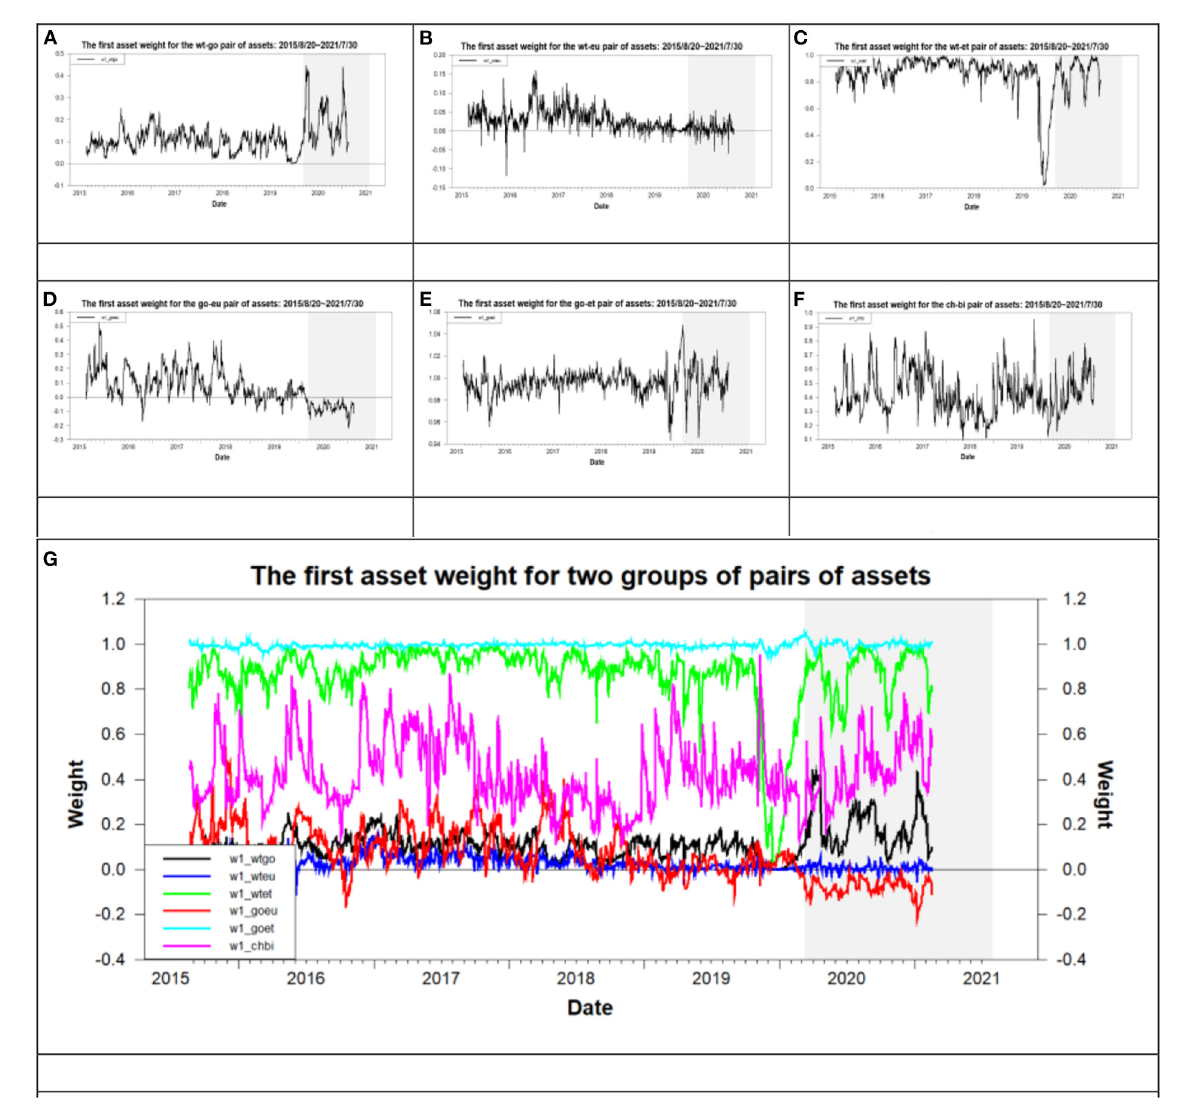
FIGURE6 The time-varying weight for six pairs of assets. (A) wt-go, (B) wt-eu, (C) wt-et, (D) go-eu, (E) go-et, (F) ch-bi, and (G) all six pairs of